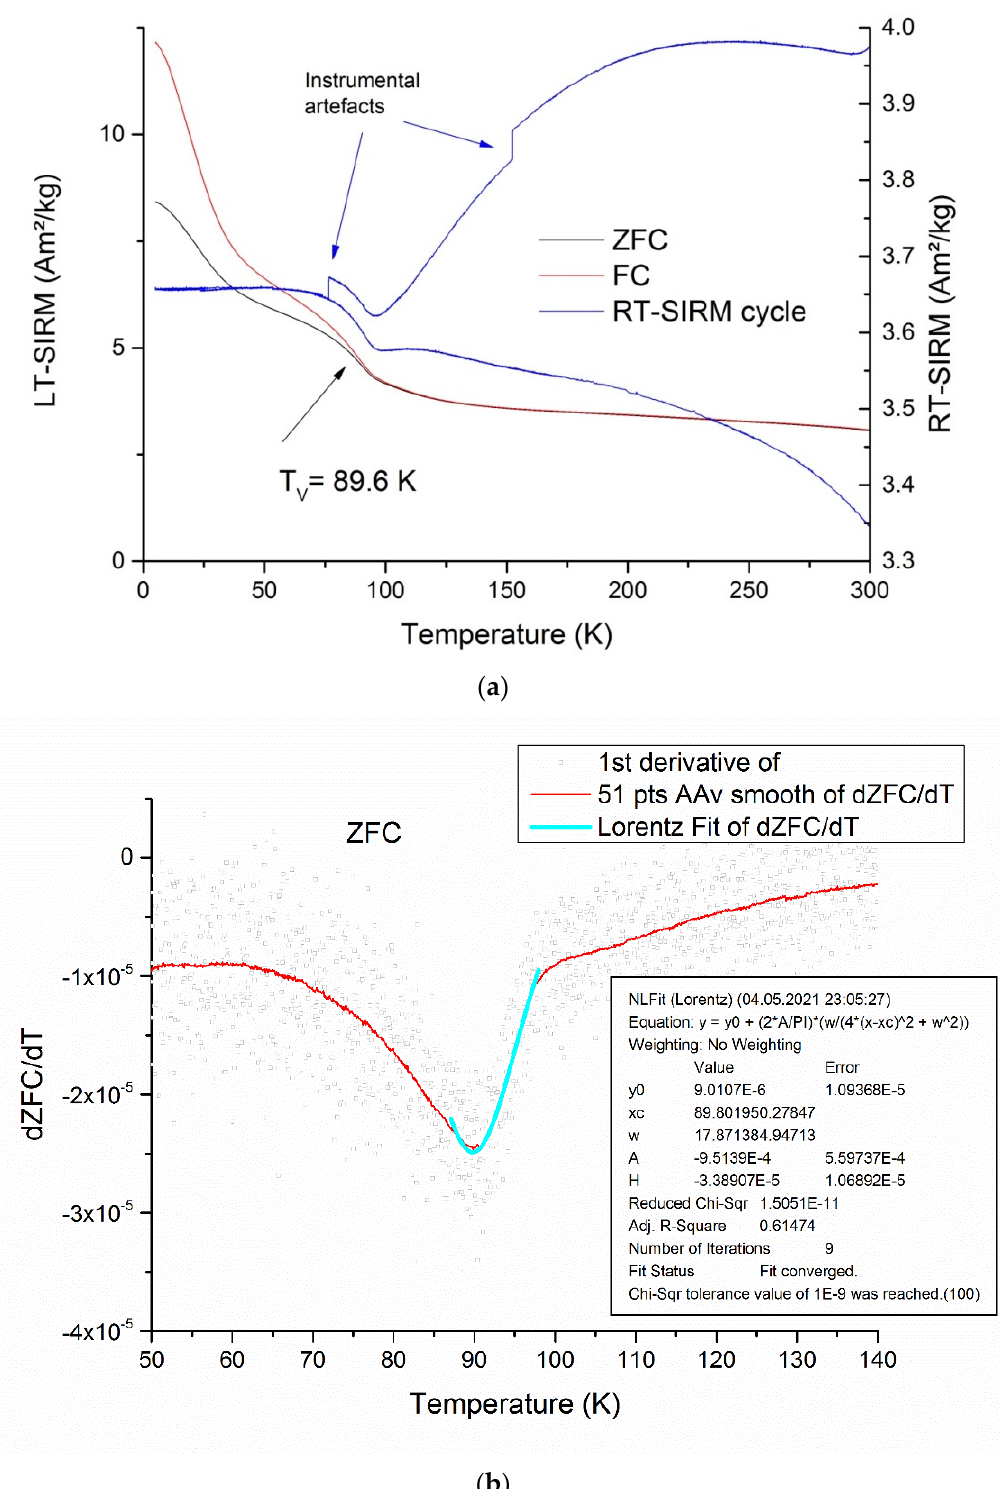
Figure 8. Thermal magnetic properties of the isolated magnetosomes: ( a ) zero field cooling (ZFC) and cooling in a strong (5 T) field remanence curves (left ordinate axis) and zero-field cycling of saturation isothermal remanent magnetization given at 300 K; ( b ) determining the Verwey transition temperature by Lorentz approximation of ZFC/dT temperature dependence.